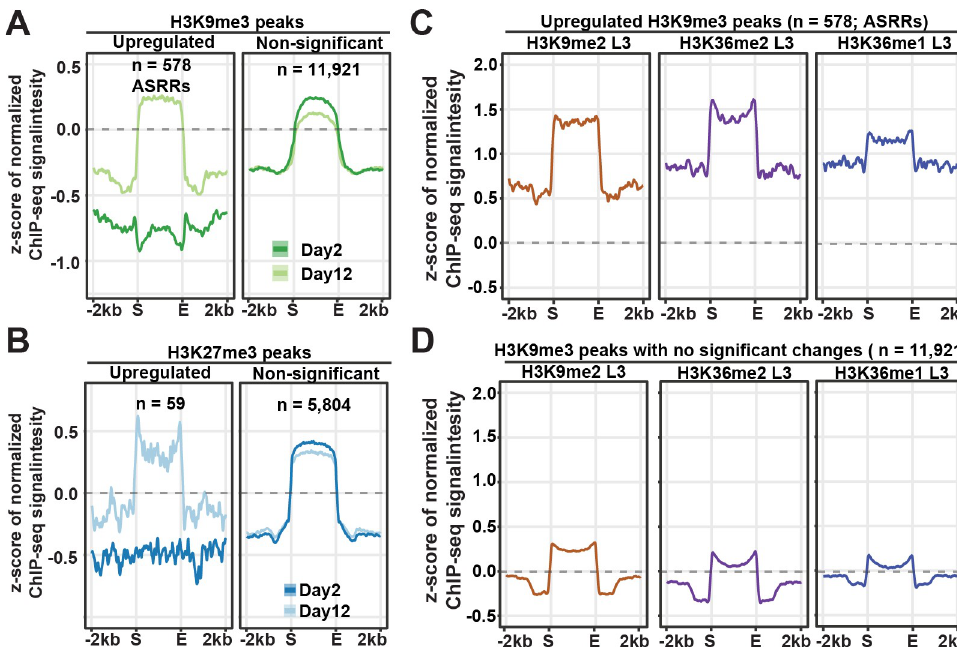
Fig 3. Age-dependent gain of H3K9me3 in regions marked by H3K9me2 and H3K36me1/2. (A-B) Metaplots showing the average z-scores of ChIP-seq signal intensity normalized to H3 (log 2 ) in H3K9me3 (A) or H3K27me3 (B) peak regions ( ± 2kb flanking regions) with significant gain or non-significant change with age. (C-D) Metaplots showing the z- scores of H3K9me2 and H3K36me1/2 ChIP-seq signal intensity in peak regions with significant gain (C) or no significant change (D) in H3K9me3 levels during aging. The grey dashed lines indicate the z-score of